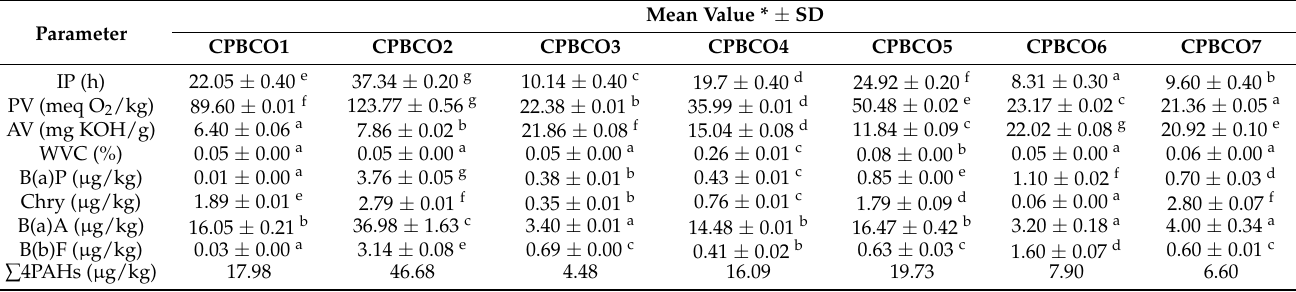
Table 5. Oxidative stability and quality parameters of cold-pressed black cumin